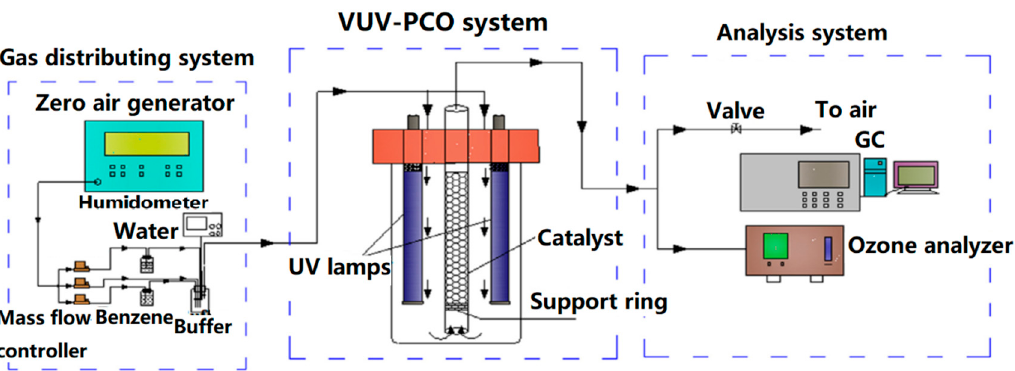
Figure 14. A 420 ‐ L of continuous closed ‐ loop photocatalytic reactor: ( 1 ) Photocatalytic unit containing the TiO 2 photocatalytic medium and the ultraviolet (UV) lamps, ( 2 ) fan, ( 3 ) air input and sampling points for analysis, ( 4 ) air tranquilization chamber, ( 5 ) flow rate measurement. Reprinted with permission from [176], 2018, Elsevier Ltd..